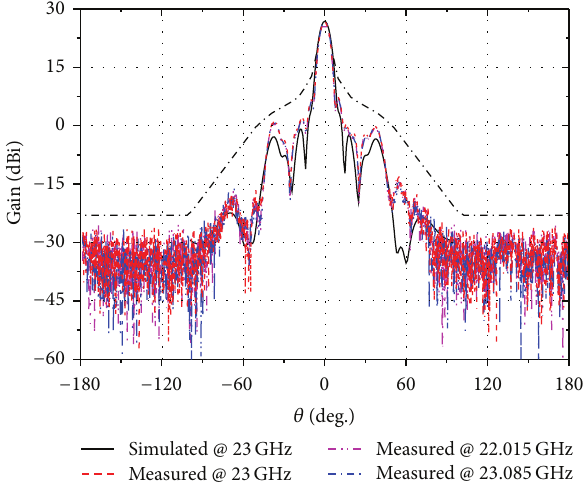
Figure 5: Simulated and measured patterns in 𝐻 -plane of the fabricated 16 × 22 SIW slot array